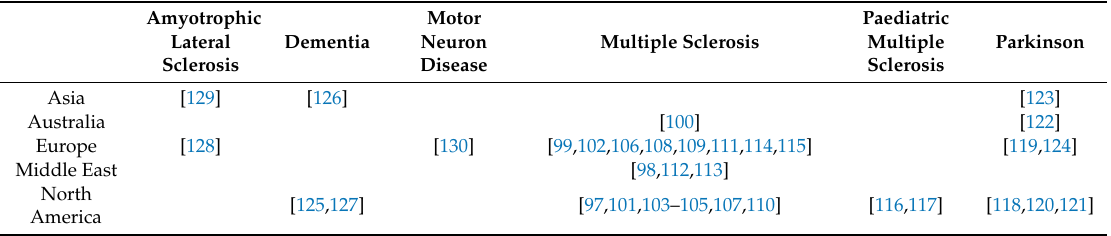
Table 4. Studies published by each geographic region, grouped by neurodegenerative